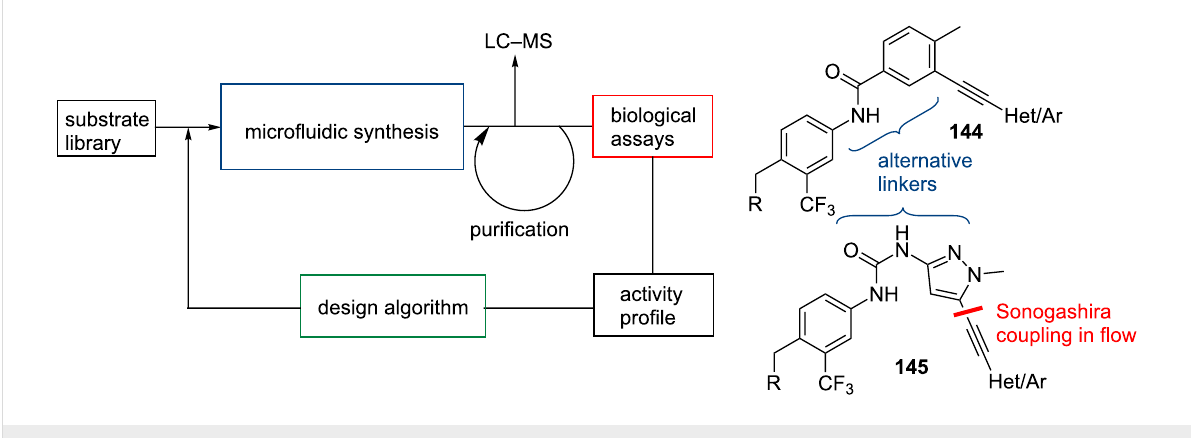
Scheme 25: Synthesis and screening loops in the discovery of new Abl kinase inhibitors.